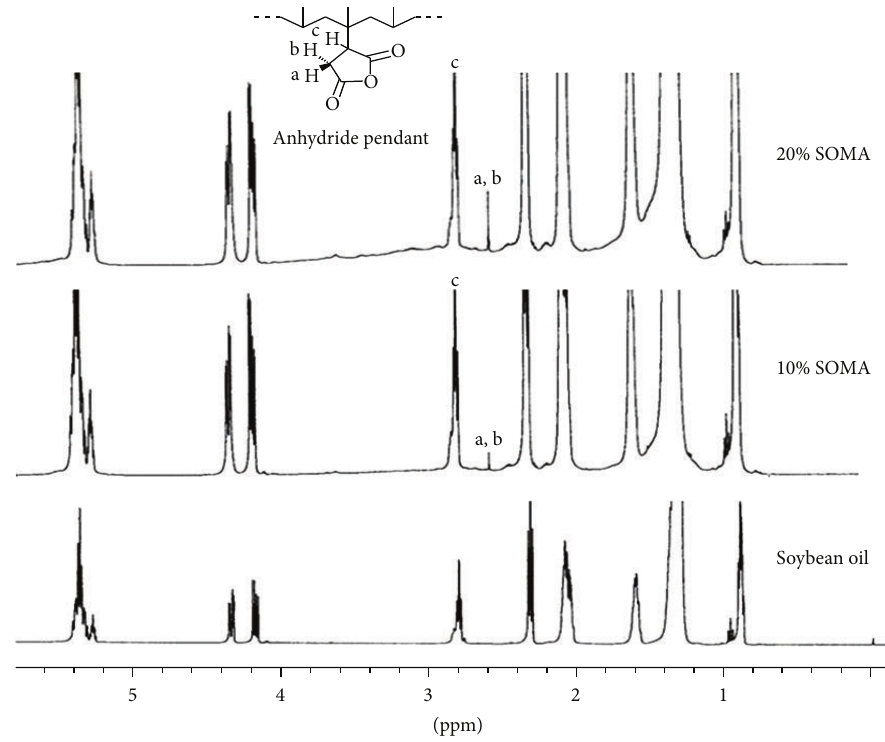
Figure 2: 1 H NMR spectra of soybean oil and soybean oil maleate.